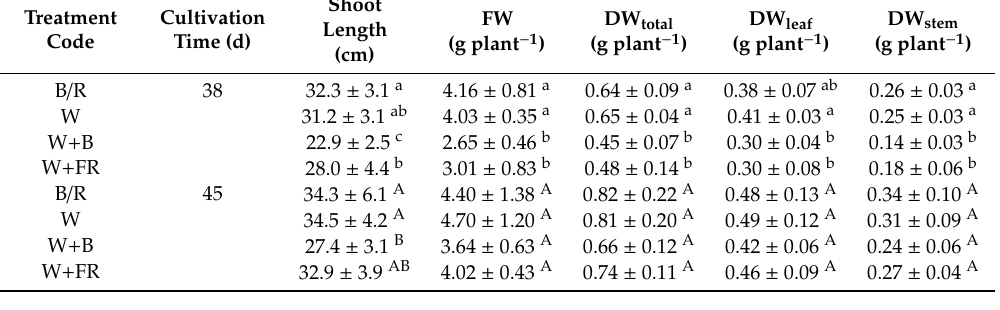
Table 1. Results on shoot length, fresh weight (FW), dry weight (DW) separately for total, leaf, and stem of marjoram on day 38 and 45, respectively. Data is shown as means ± SD ( n = 9). Di ff erent letters in each column represents significant di ff erences between light treatments at p < 0.05, determined according to Tukey’s test.